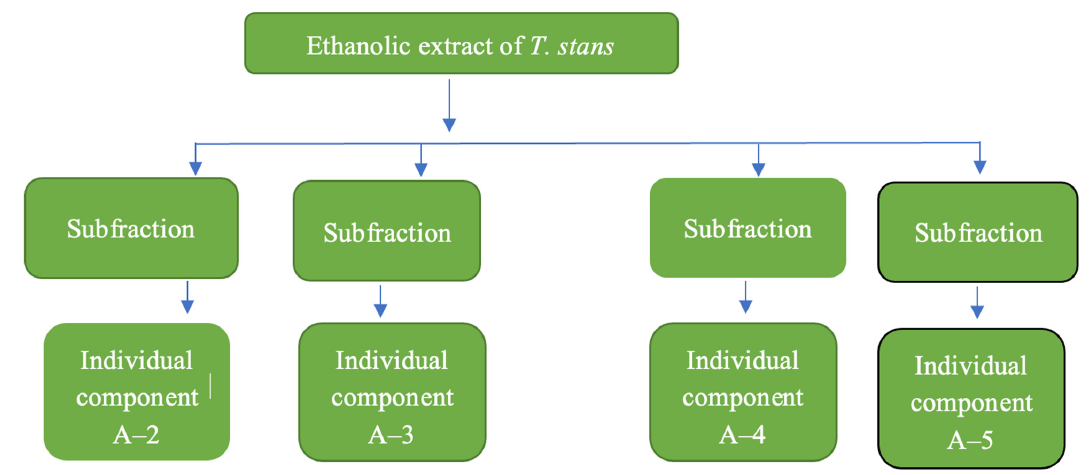
Figure 2. Flow chart of the subfractions/individual components.